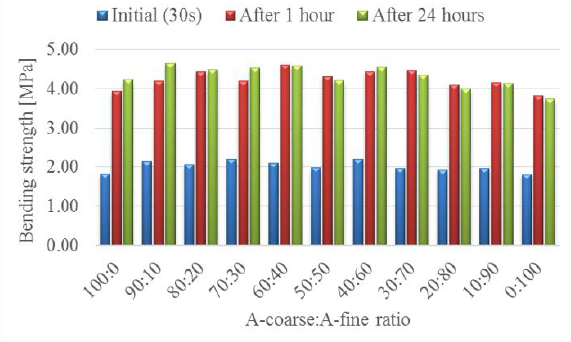
Figure 12. Strength behavior for sand combination A coarse and A fine.